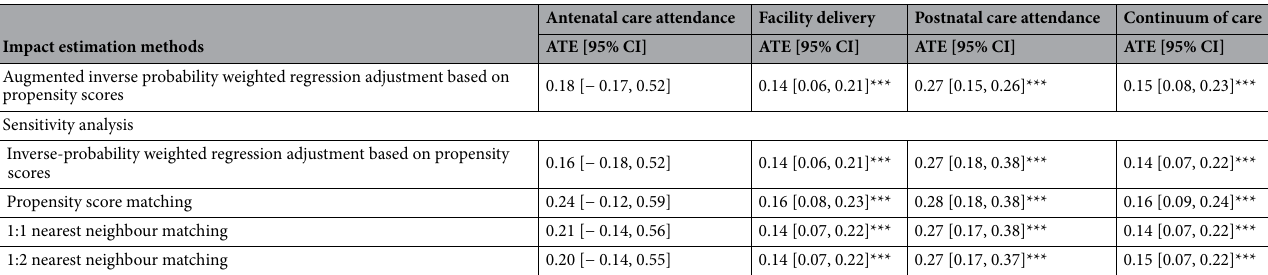
Table 2. Impact of T4MCH intervention on antenatal care attendance, skilled delivery, postnatal care attendance and continuum of care in the Sawla-Tuna-Kalba districts. ATE is the average treatment